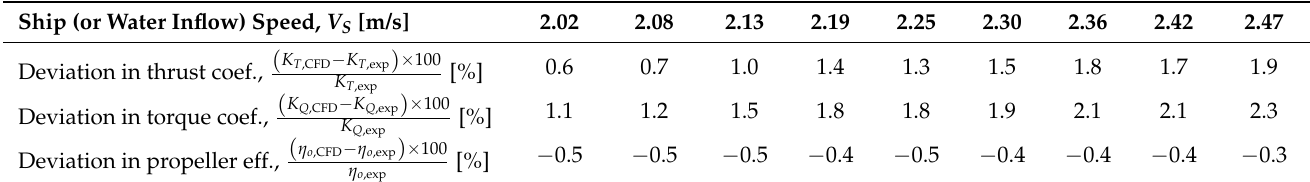
Table 6. Validation of CFD with testing results for the original model-scale propeller/rudder